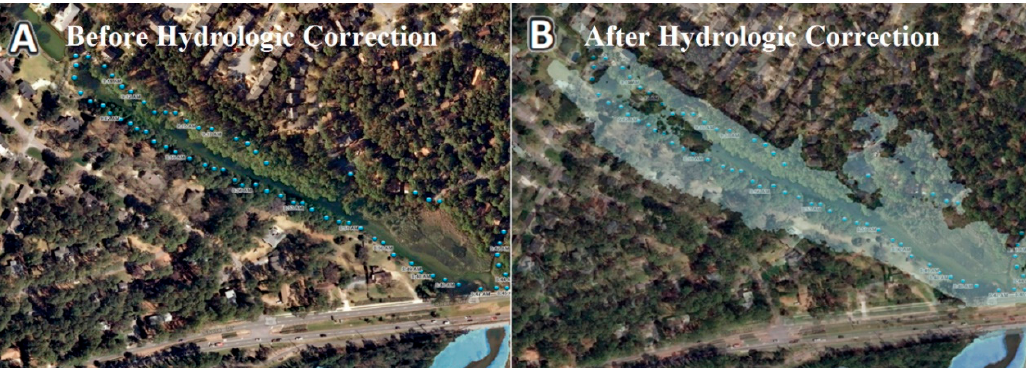
Figure 14. Citizen Science flood extent observations aided in hydrologic correction for an ephemeral stream feeding Wolfsnare Creek in Virginia Beach, VA. ( A ) Citizen scientists mapped the tidal inundation extent approximately an hour before the king tide’s peak. ( B ) Hydrologic correction fixed the lidar-derived DEM to permit flow through the small box culvert beneath the bridge to enhance the model’s spatial accuracy via better estimation of cross-sectional flow and volume conservation.